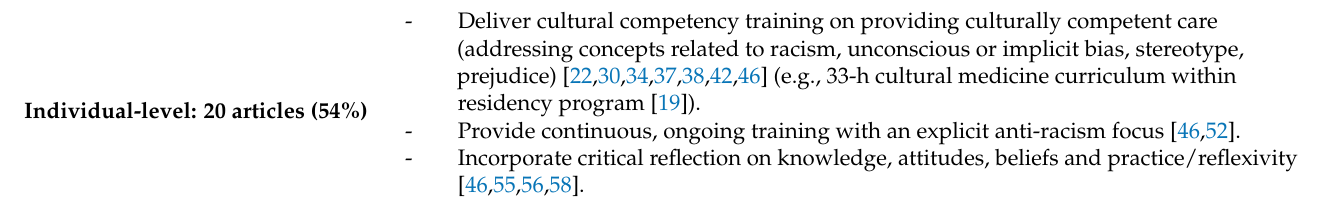
tion level. Table 2. Examples of anti-racism interventions in healthcare settings by intervention-level.